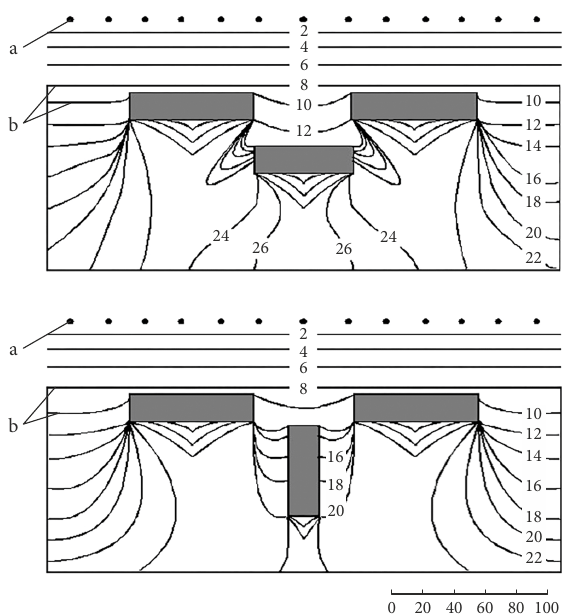
Figure 2. Nomogram for determining the level of noise pollution of the roadside area